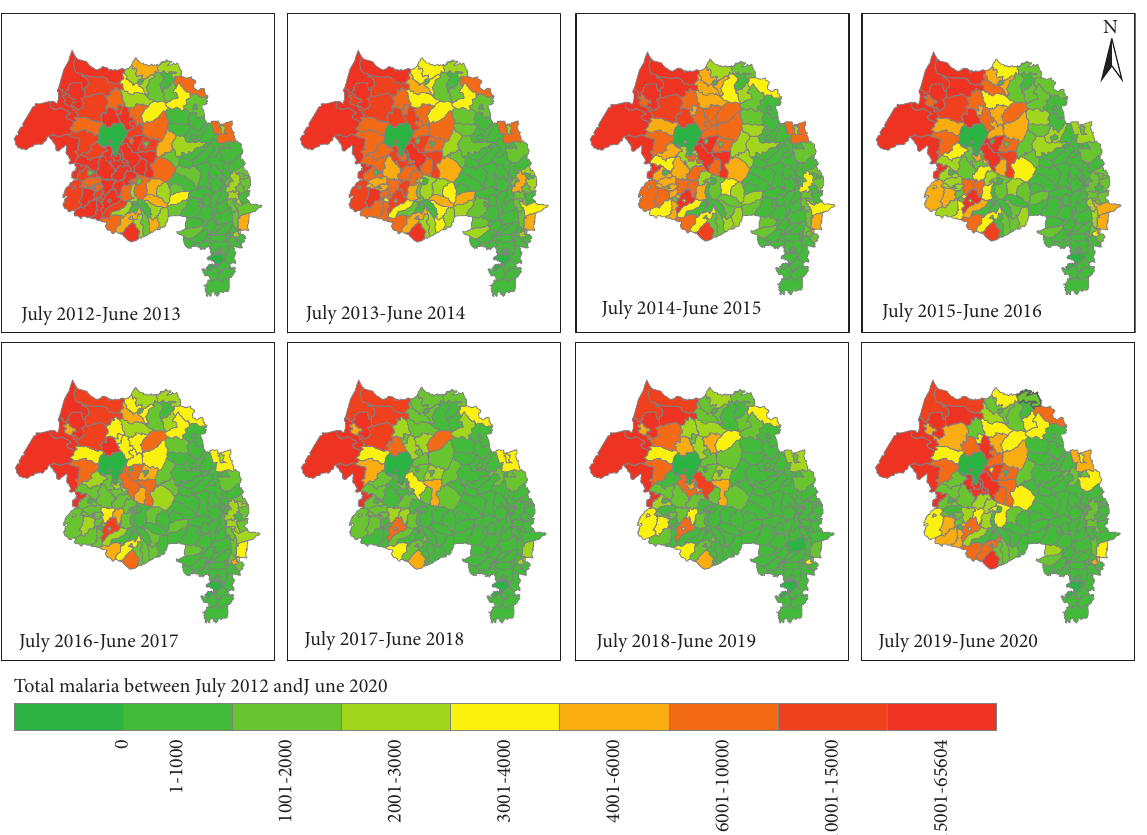
Figure 3: Spatial and temporal distribution of malaria incidences of districts in Amhara region, Ethiopia between 2012 and June Table 2: Model comparisons of parametric and nonparametric spatiotemporal dynamics of malaria incidence. Model